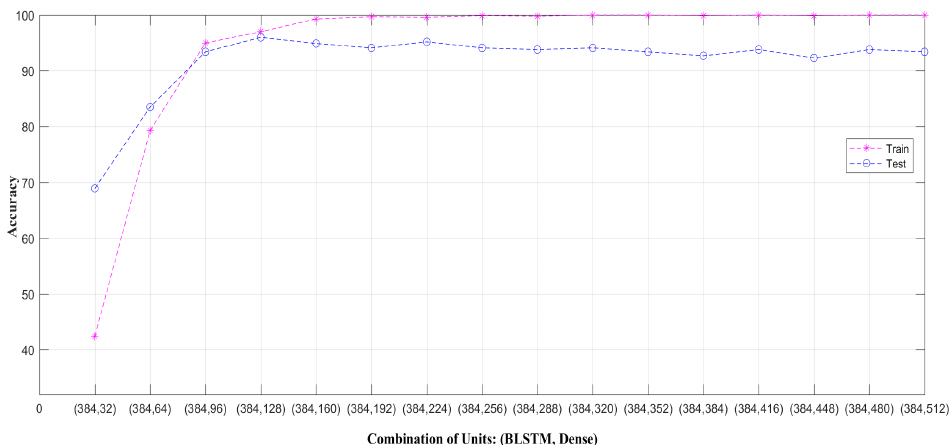
Figure 5. Setting of units on MSRAction3D in four BLSTM and three dense layers. Each result is regarding the combination (along the x-axis) of 384 BLSTM units and the number of dense layer units in the range of 32 ∼